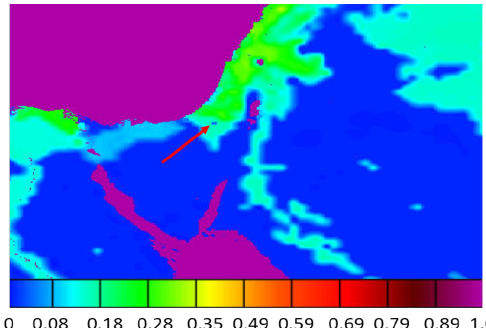
Fig. 7. ECMWF soil moisture initialization data for the second soil layer in NOAH (10–40cm). The re-initialization of the soil moisture within the plantation can be seen on the image marked with a red arrow where there is a small patch which is much drier than the surroundings.